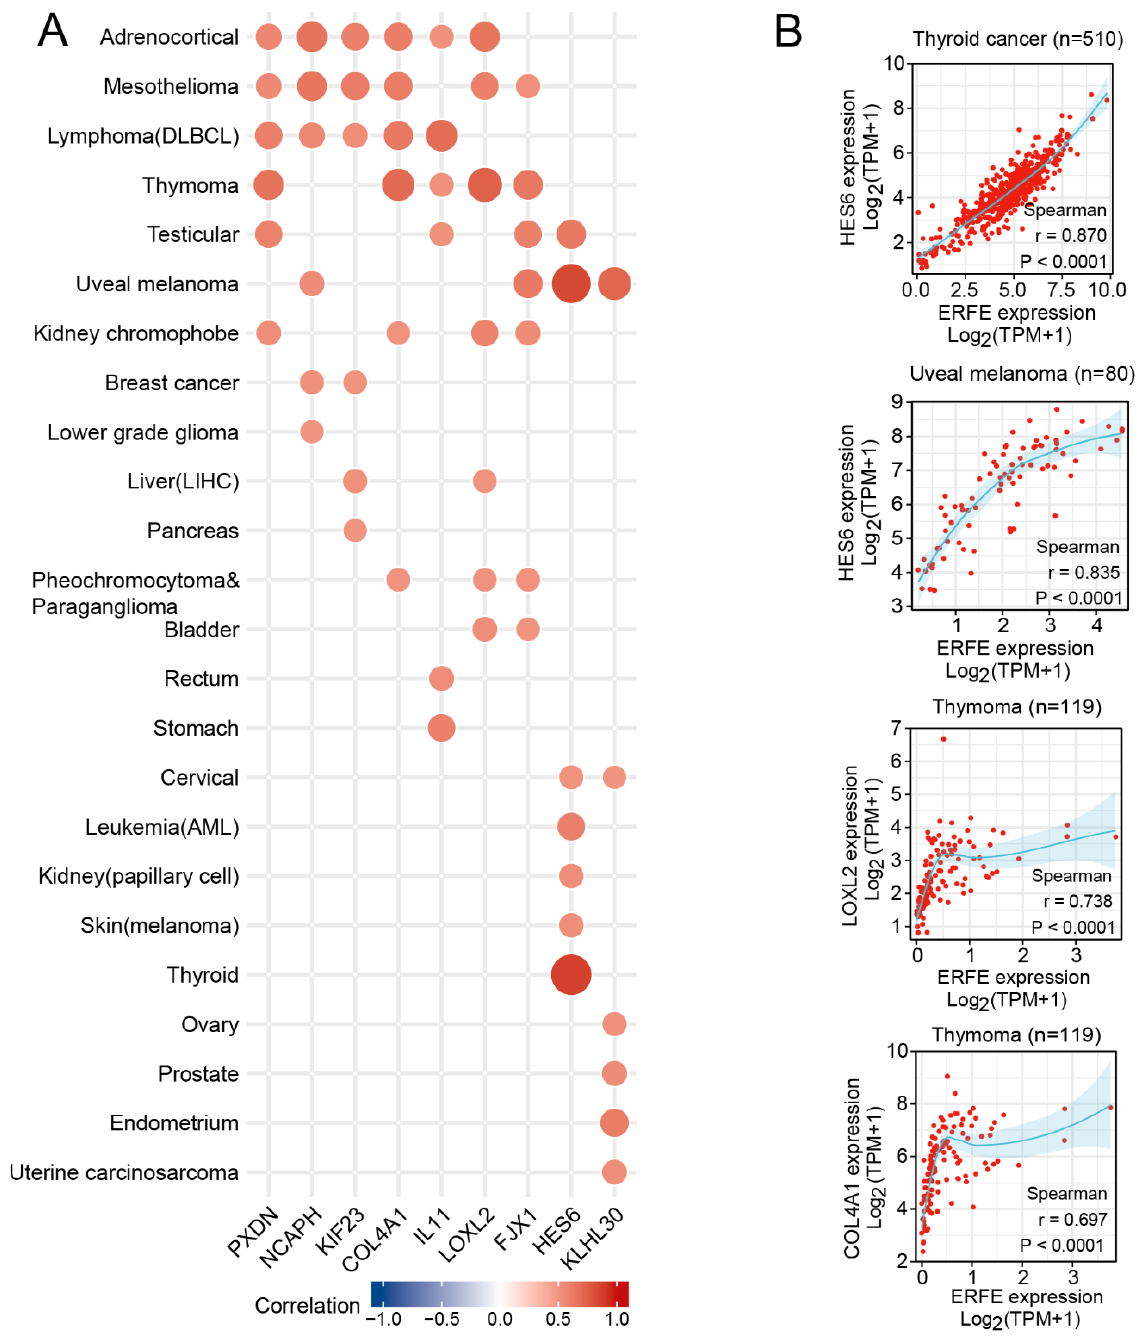
Figure 6. Expression correlation between ERFE and other functional genes. Spearman’s rank cor- relation test was carried out for each tumor type. ( A ) Genes with Spearman r threshold > 0.5 and p < 0.0001 were listed when covering at least six tumor types. ( B ) Examples of genes with Spearman r threshold > 0.6 and p < 0.0001 were shown in thyroid cancer, uveal melanoma, and thymoma.